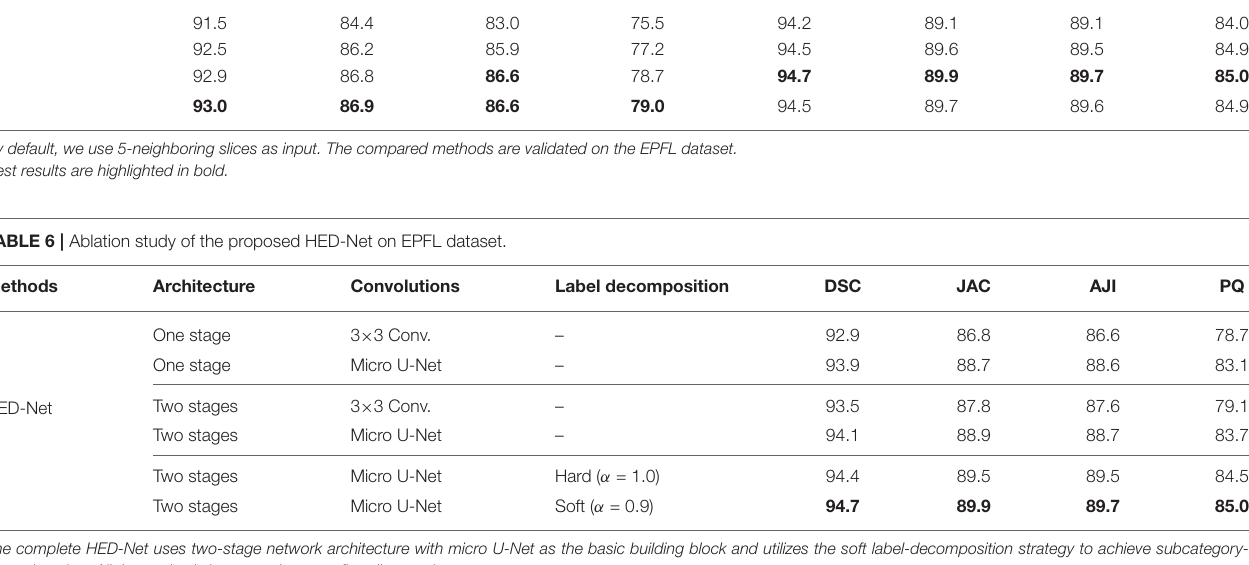
TABLE 4 | The impact of using varying number of input slices on the segmentation performance. Input